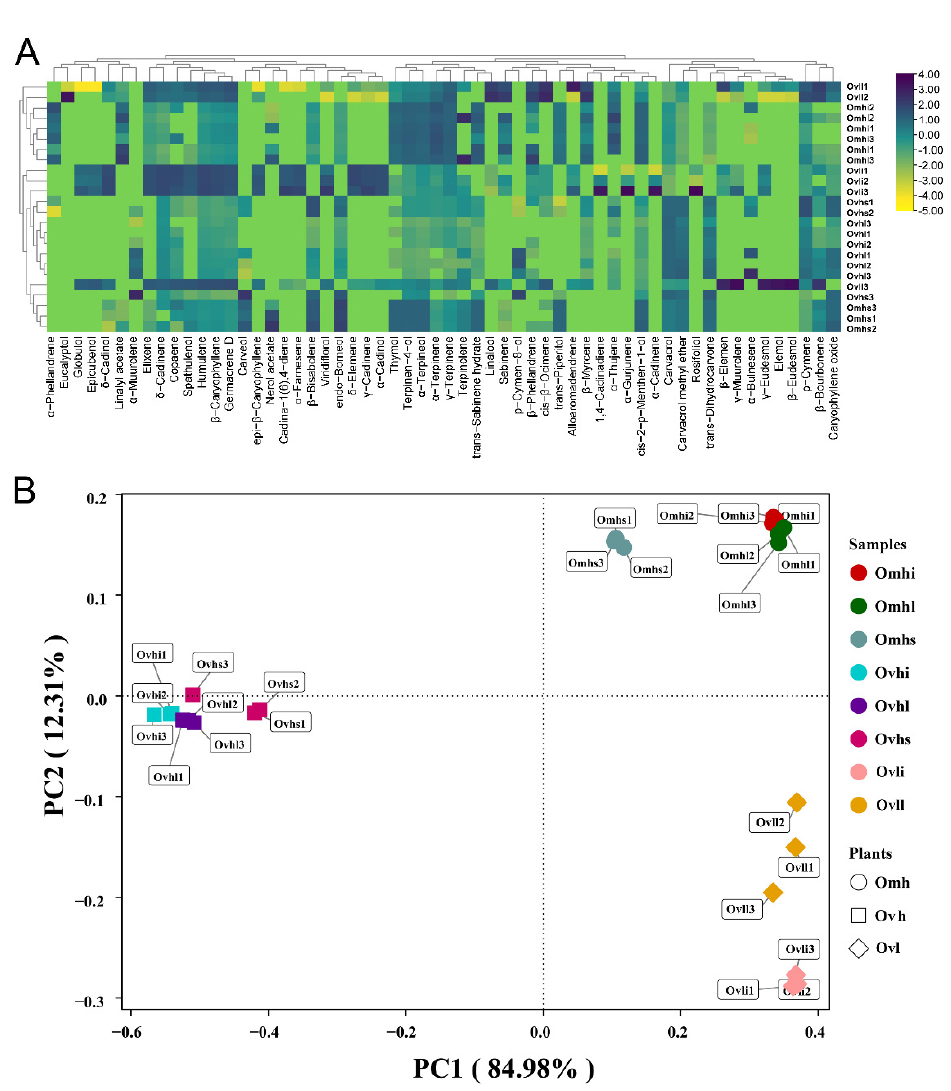
Figure 2. Heatmap ( A ) and principal component analysis (PCA) map ( B ) based on the chemical components of oregano essential oils (OEOs).